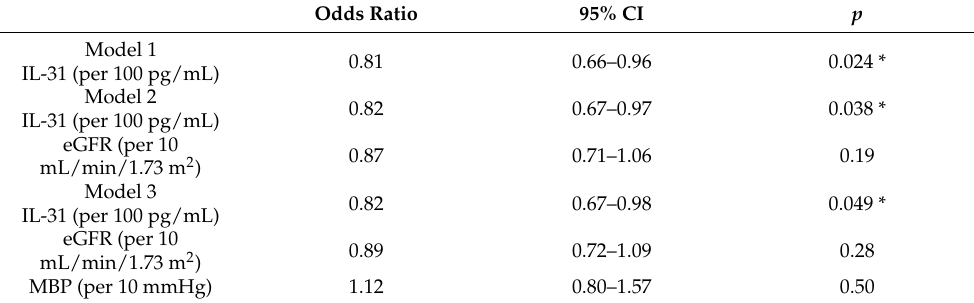
Table 4. Multivariate odds ratios for proteinuria ( ≥ 1.0 g/gCr) in different models including serum IL-31 in IgAN.